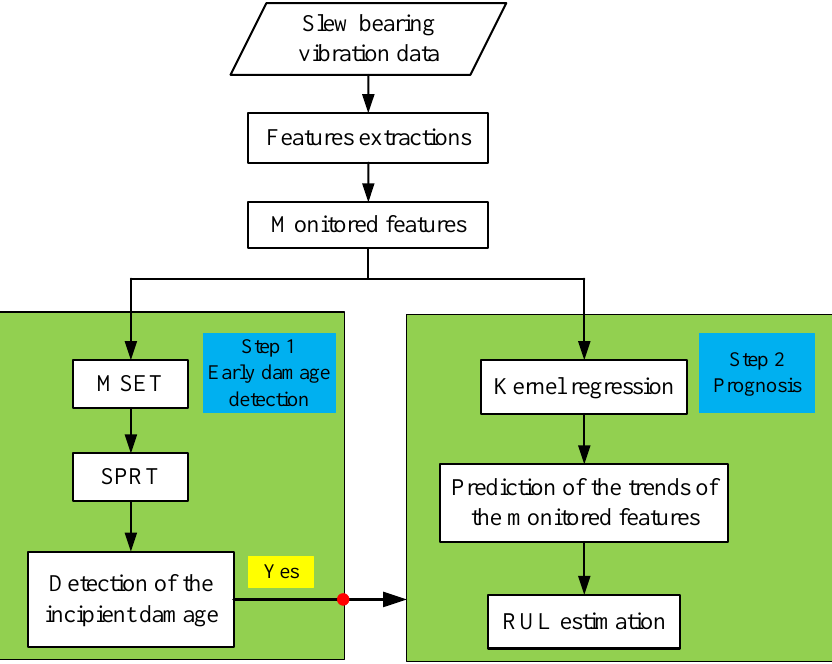
Figure 1. The integrated condition monitoring and prognosis method for low speed slew bearing.